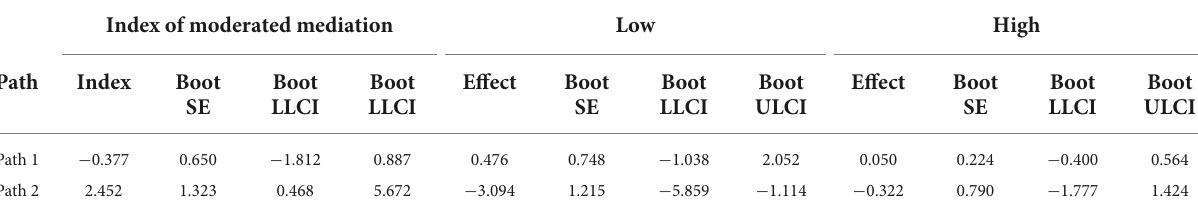
TABLE 3 Indices of moderated mediation with 95% bootstrap confidence